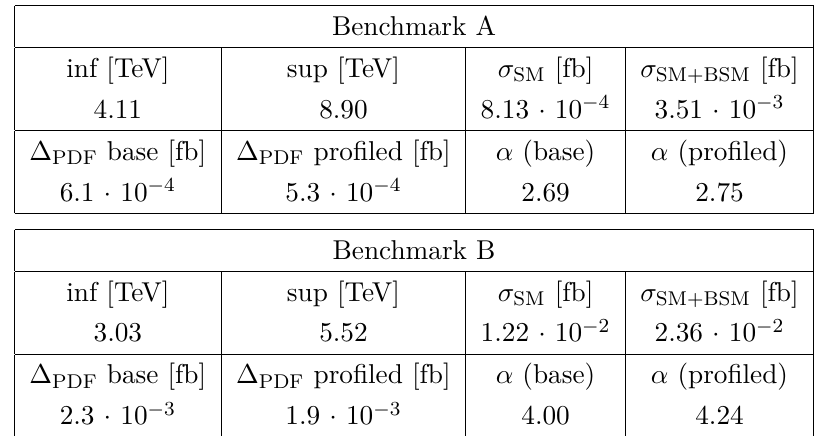
Figure 7 . Number of events as function of the system transverse mass for benchmark A (left) and benchmark B (right) with 3000 fb − 1 of integrated luminosity.